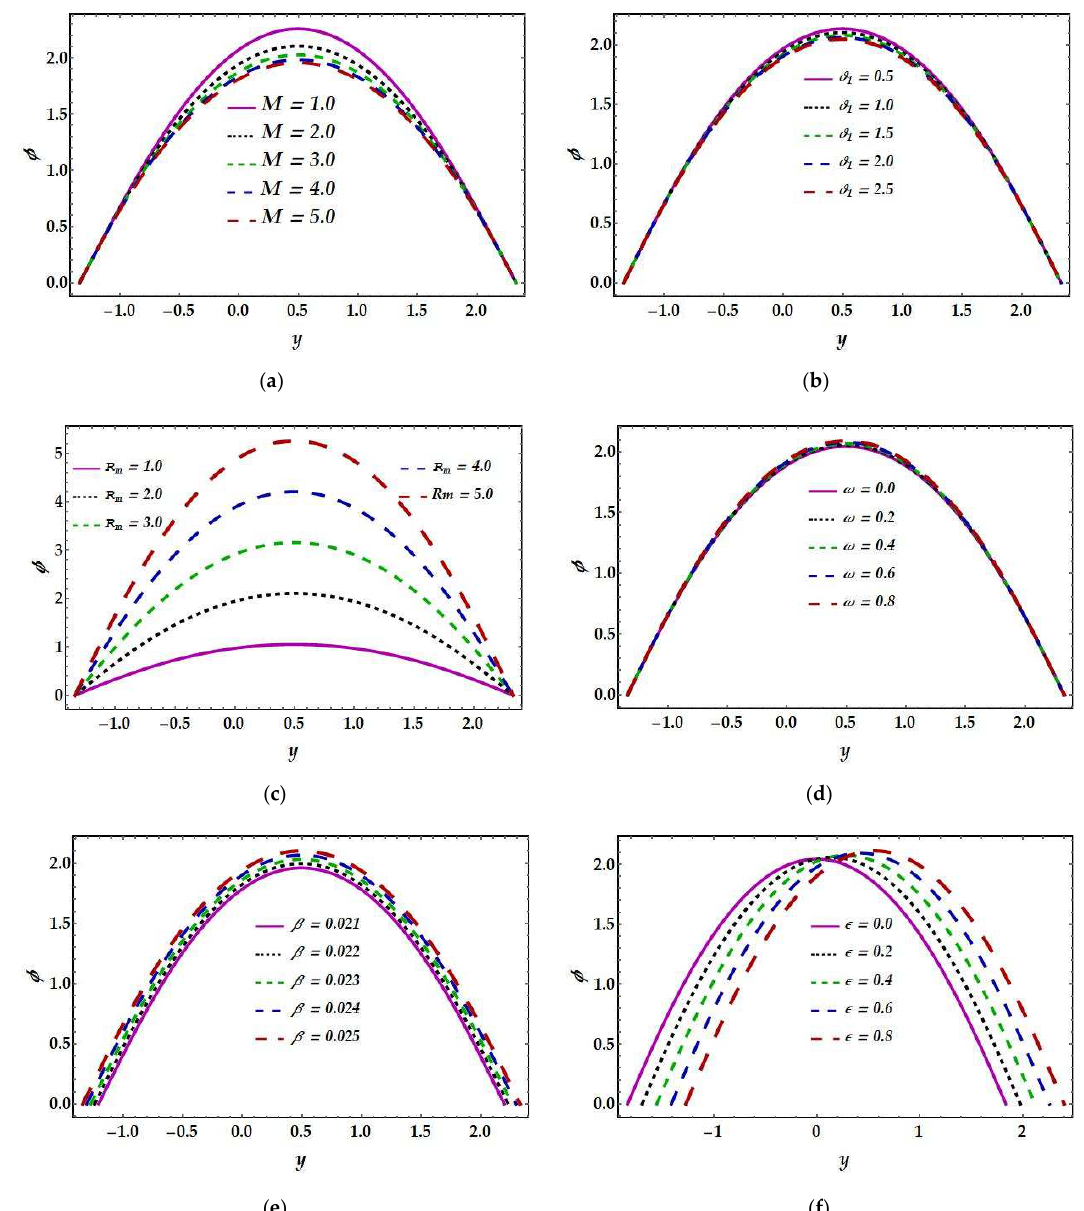
Figure 3. Effects of different physical parameters on magnetic force functions φ